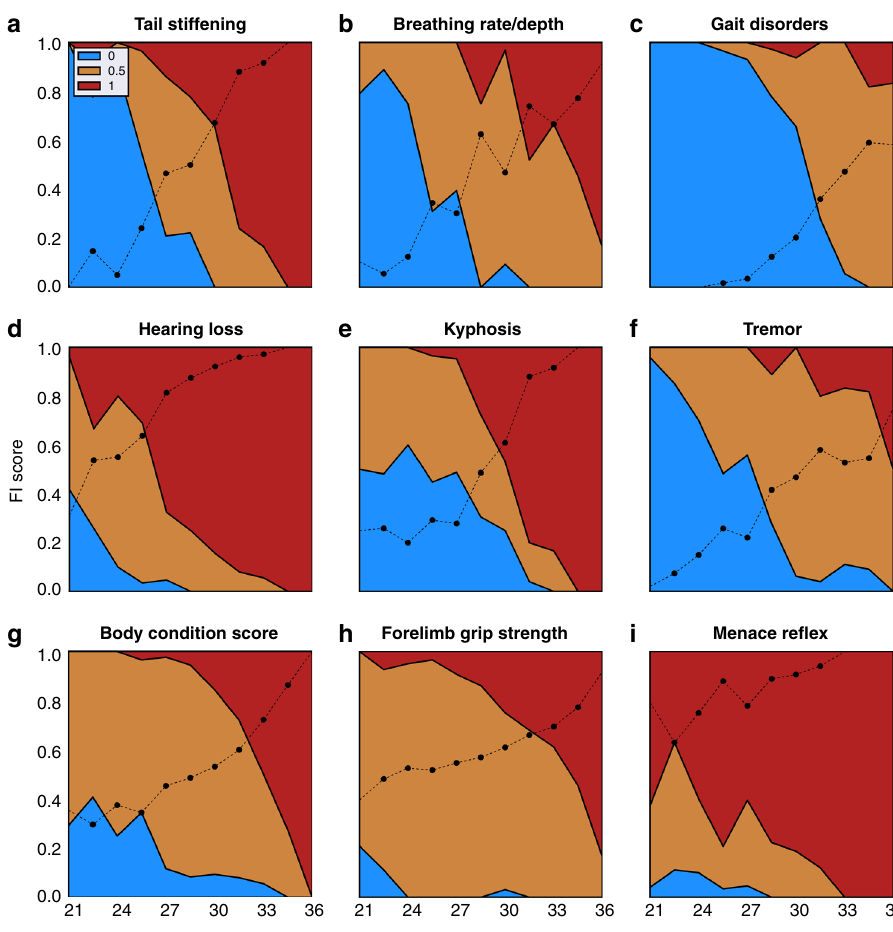
Fig. 2 Individual FI items vary in their correlation with age. Mean scores across all mice (black line) for the top nine individual items of the Frailty Index (FI) that were correlated with chronological age. Colors indicate proportion of mice at each age with each score (0, blue; 0.5, orange, 1, red). Source data are provided as a Source Data fi